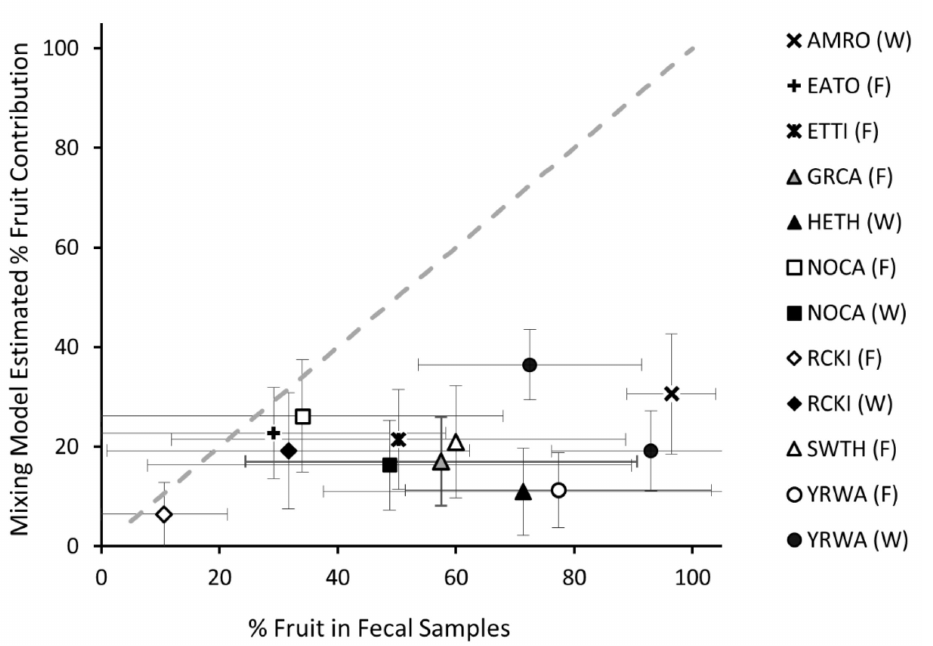
Figure 4. The relationship between fecal and mixing model estimates of fruit contributions to song- bird diets. Points represent population-level means calculated for a given species and season (F = fall, W = winter), while error bars depict standard deviations. The dashed grey line depicts a 1:1 match between fecal and mixing model estimates and points below the line indicate that fecal estimates are larger than mixing model estimates.Species codes: AMRO = American Robin; DEJU = Dark-Eyed Junco; EATO = Eastern Towhee; ETTI = Tufted Titmouse; GRCA = Gray Catbird; HETH = Hermit Thrush; NOCA = Northern Cardinal; RCKI = Ruby-Crowned Kinglet; and SWTH = Swainson’s Thrush; WTSP = White-Throated Sparrow; and YRWA = Yellow-Rumped